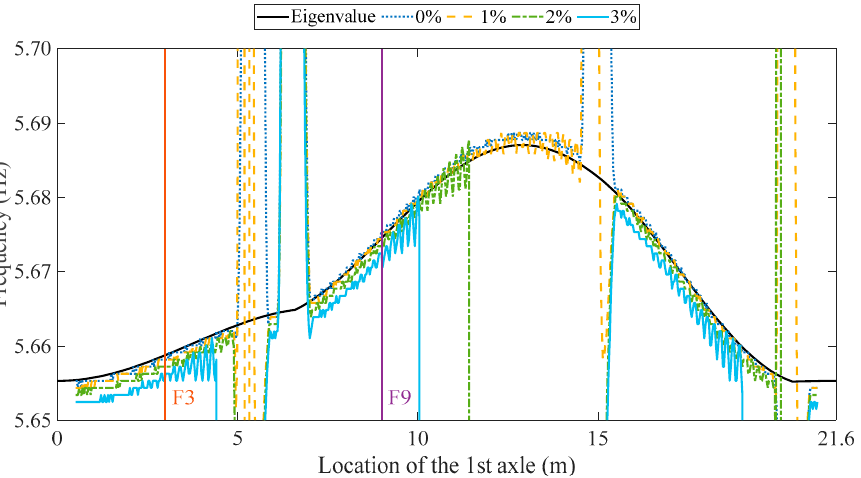
Figure 8. Comparison of the eigenvalue curve and the STFT of the bridge response due to the truck traveling at 1 m/s on a smooth profile for four bridge damping ratios.